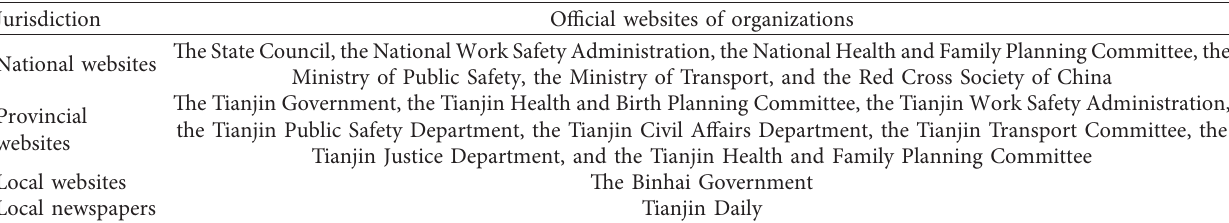
Table 1: Sources of some key organizational websites and